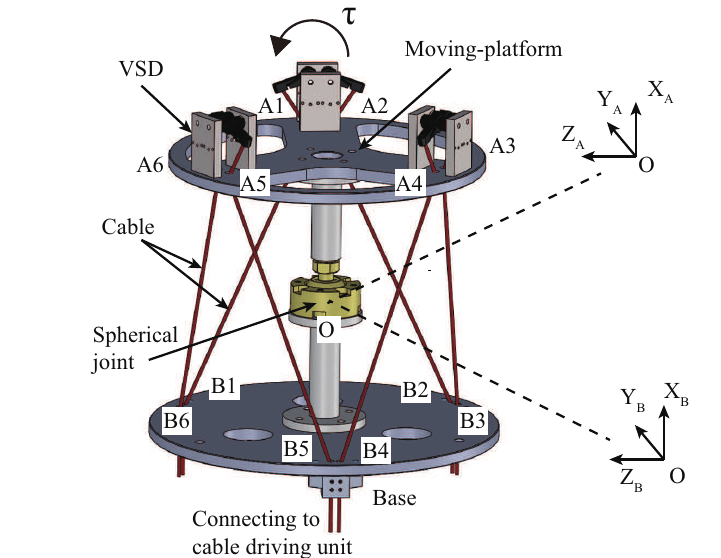
Figure 4. CAD model of the